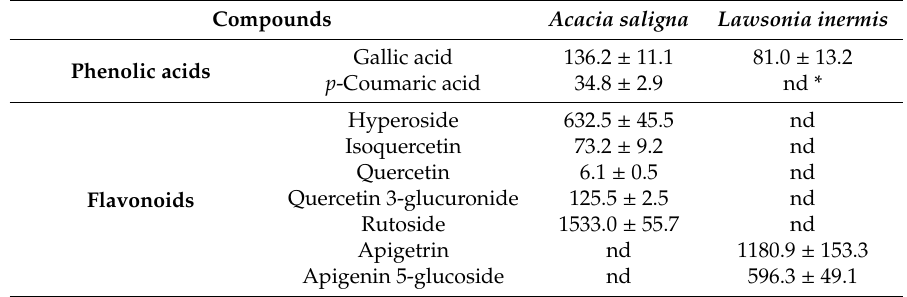
Values are expressed as mean ± standard deviation (SD). nd * not detected.